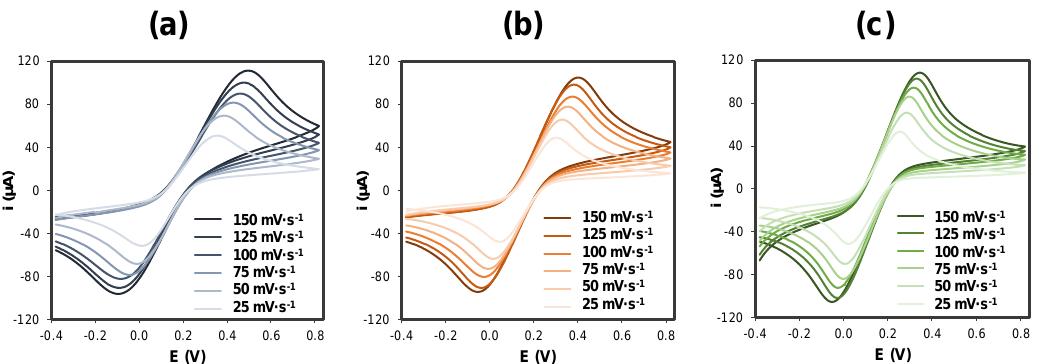
Figure 1. Cyclic voltammograms recorded with bare and modified GSPEs in an equimolecular solution of 5 mM ferro / ferricyanide ([Fe(CN) 6 ] 4 − / 3 − ) in 0.1 M KCl. ( a ) GSPE; ( b ) PLL / GSPE and ( c ) AuNPs@PLL / GSPE. Experimental parameters: potential range from − 0.4 V to + 0.8 V; scan rate: 25, 50, 75, 100, 125 and 150 mV · s − 1 .